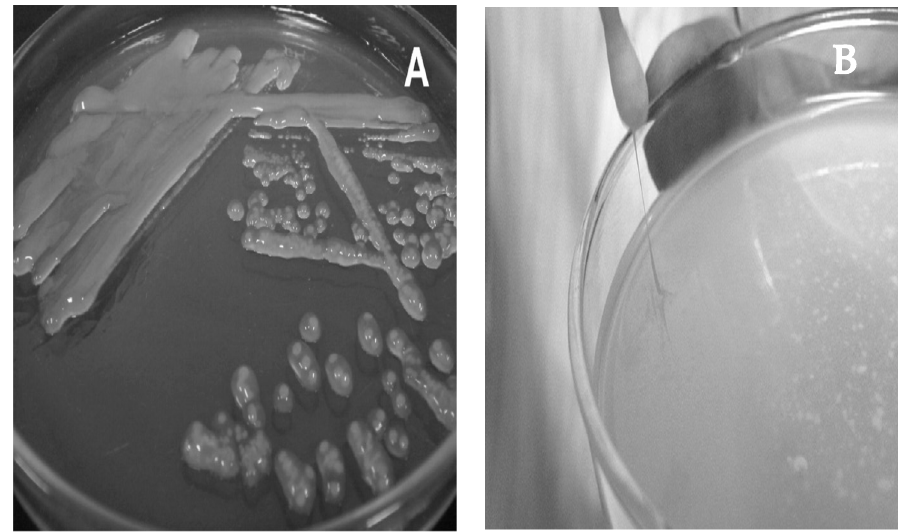
Figure 2. ( A ) Slimy colonies of L. kefiranofaciens 1P3 in medium containing sucrose [33]. ( B ) Ropy behavior of colonies of L. kefiranofaciens ZW3 [21].